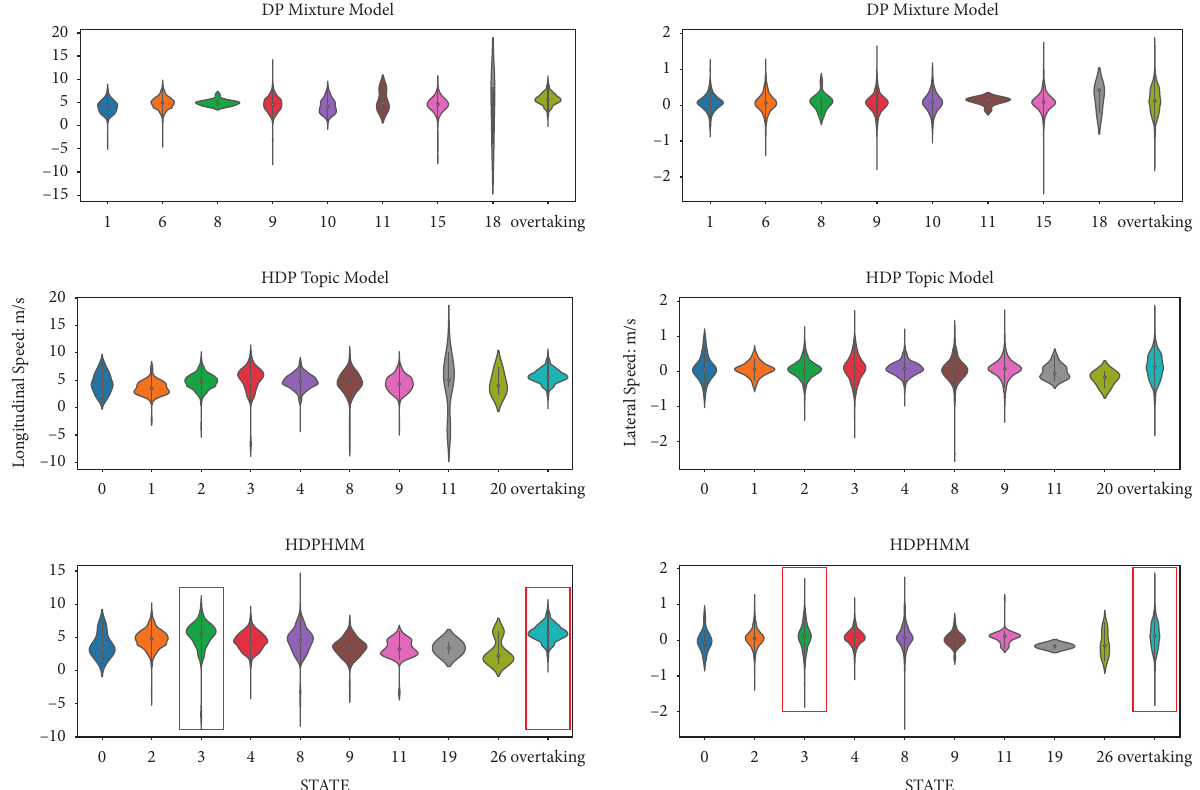
Figure 10: Statistical differences in features between